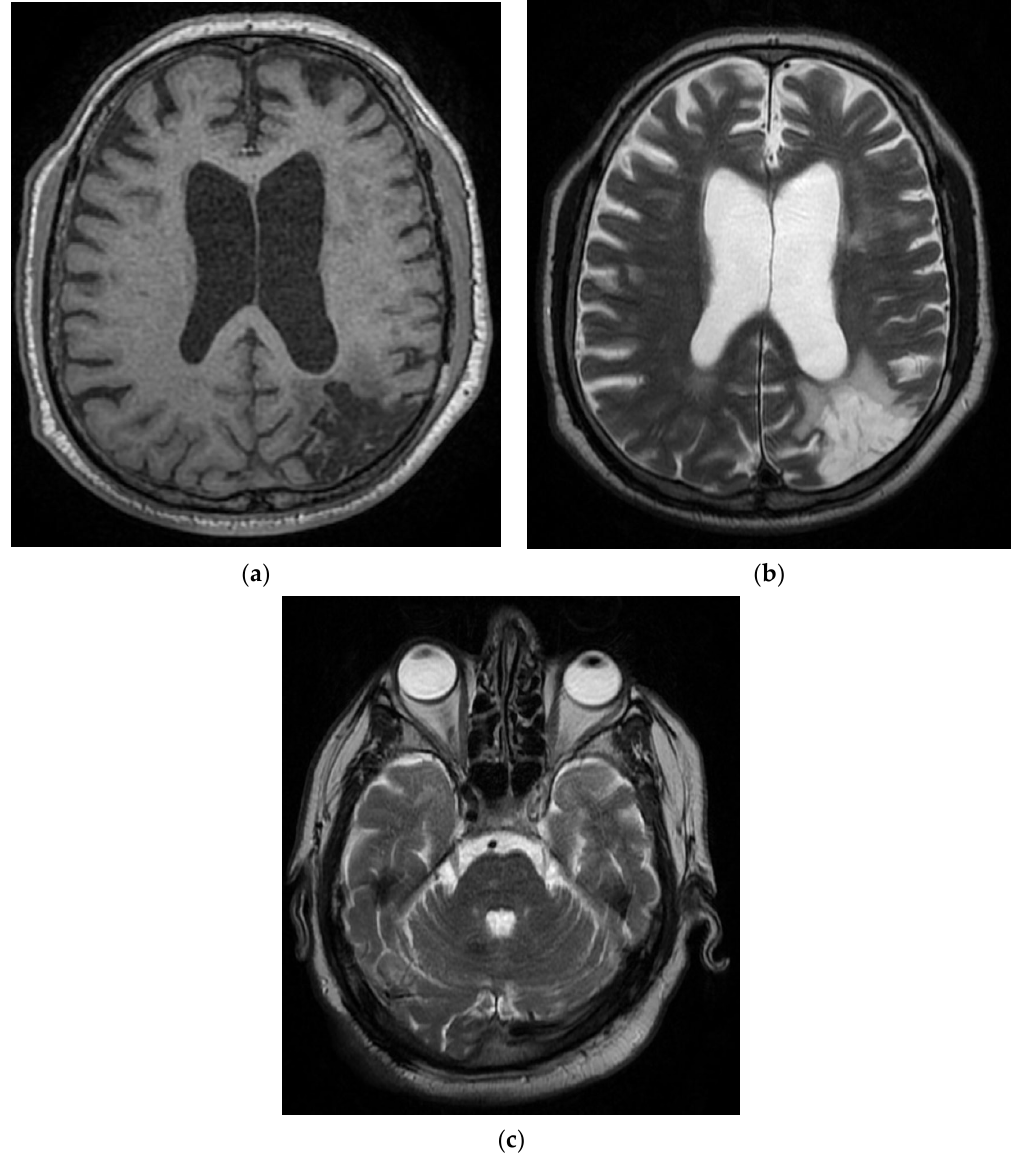
Figure 4. T1 and T2 MRI sequences in the Case 4 patient reveal left porencephalic–gliotic cortical– subcortical parietal–occipital, with a minor retractile effect on the left lateral ventricle; ischemic chronic softening on the left Sylvian territory and on the superficial territory at the border of the median cerebral artery–left posterior cerebral artery ( a , b ). The T2 MRI sequence shows the left internal carotid artery without a signal of circulatory flow in the intracranial segments ( c ); the rest of the big arteries located at the bases of the brain with no modifications of intraluminal signal that can be observed on the parenchymal sequences; occlusion of the left internal carotid artery ( c